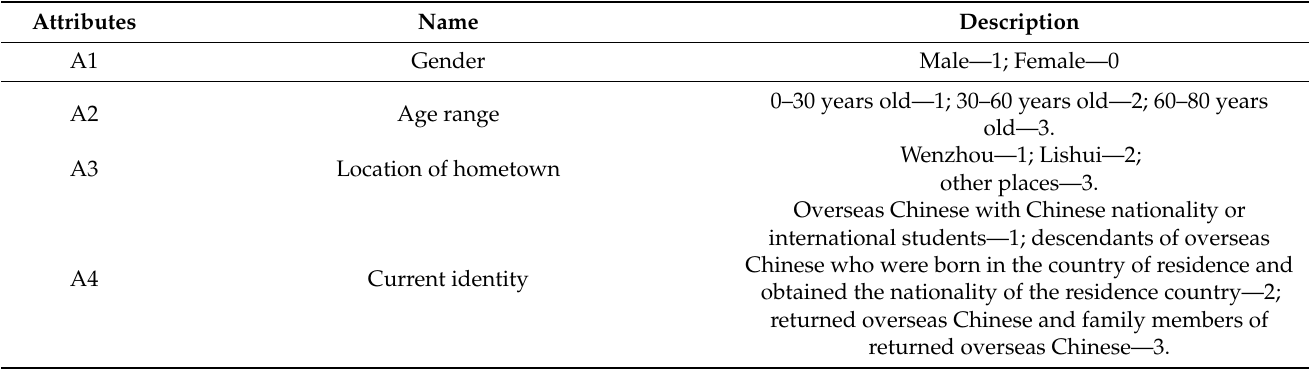
Table 2. Description of the 28